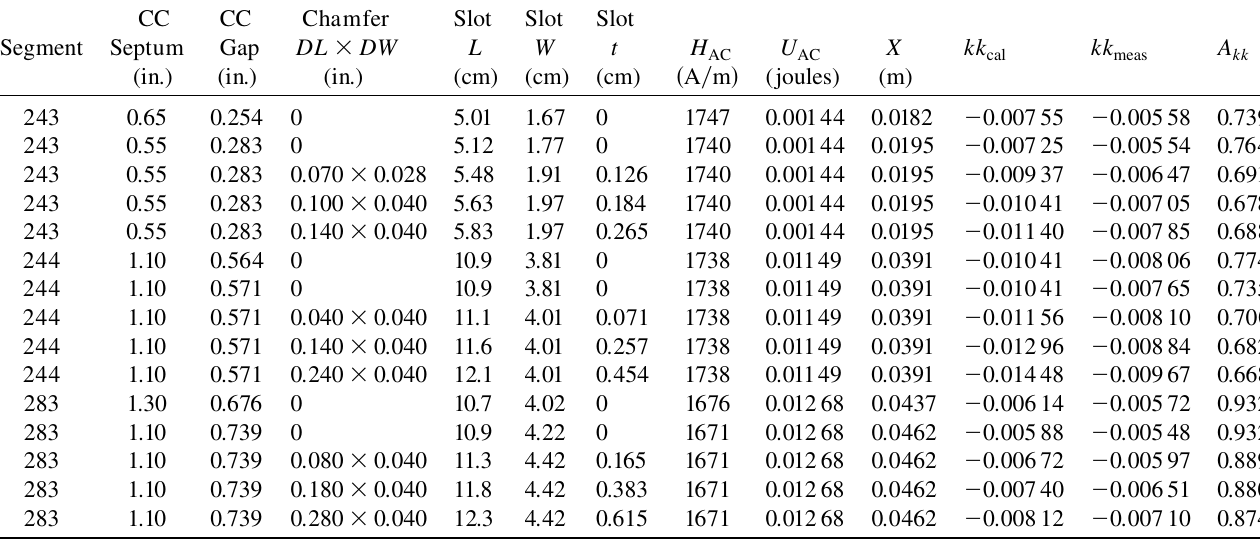
TABLE I. Dimensions and data for stacked